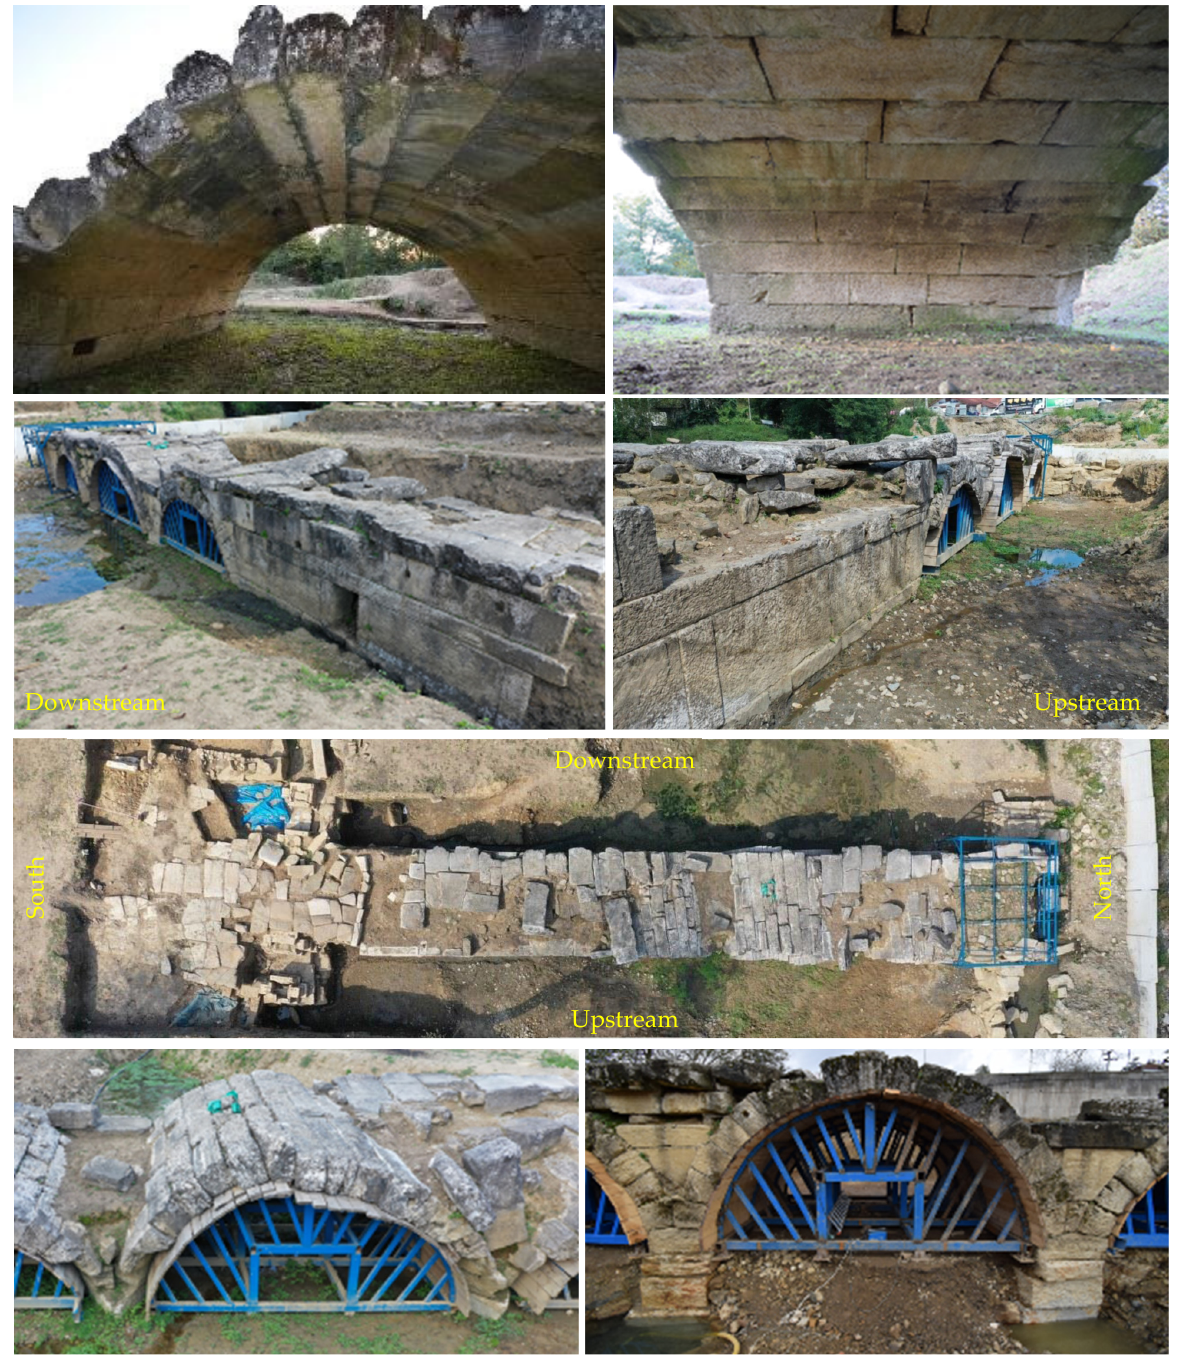
Figure 6. Site photographs of the case study bridge.